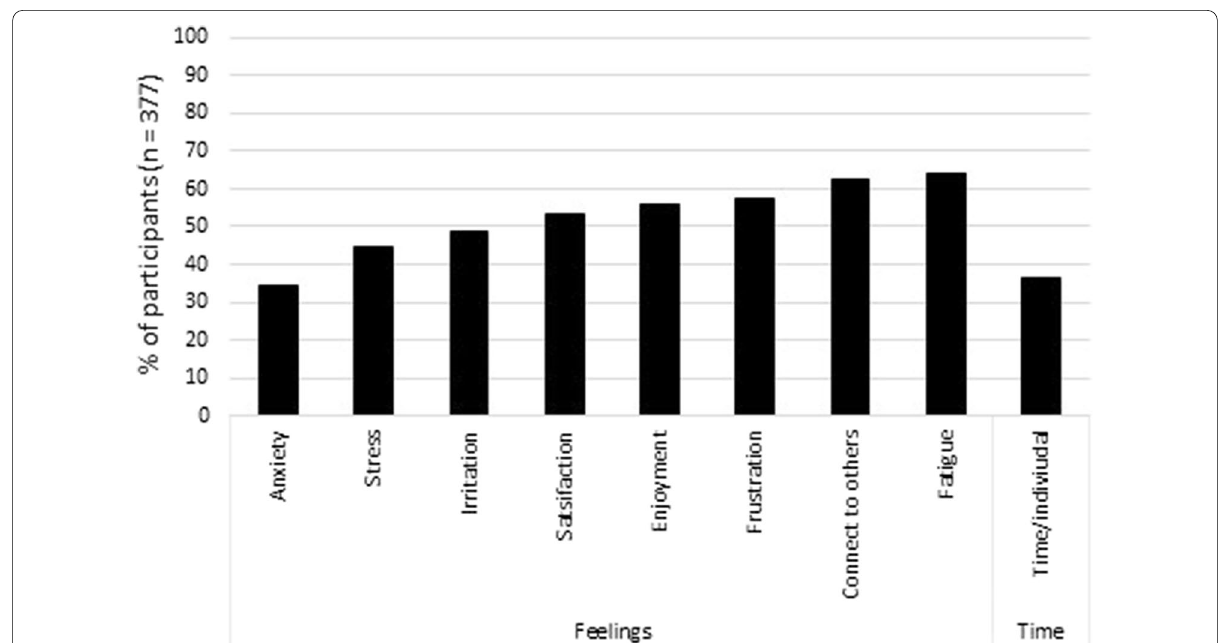
Fig. 7 Percentage of the total group of participants who reported communicating with other people wearing face masks in the workplace ( n 377) who reported a worsened outcome on feelings related to communication, and decreased time spent =